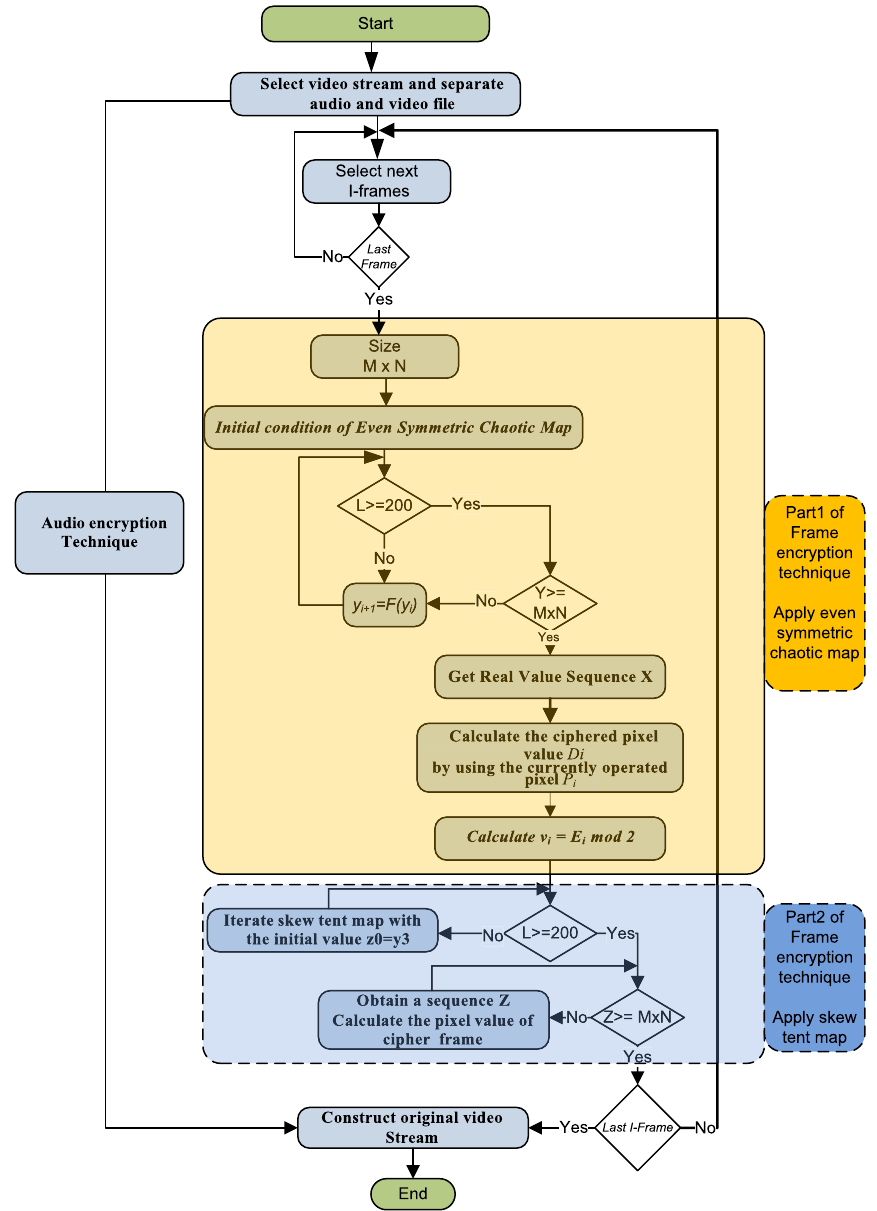
Fig. 3 Flowchart of video encryption using selective even symmetric and skew tent chaotic